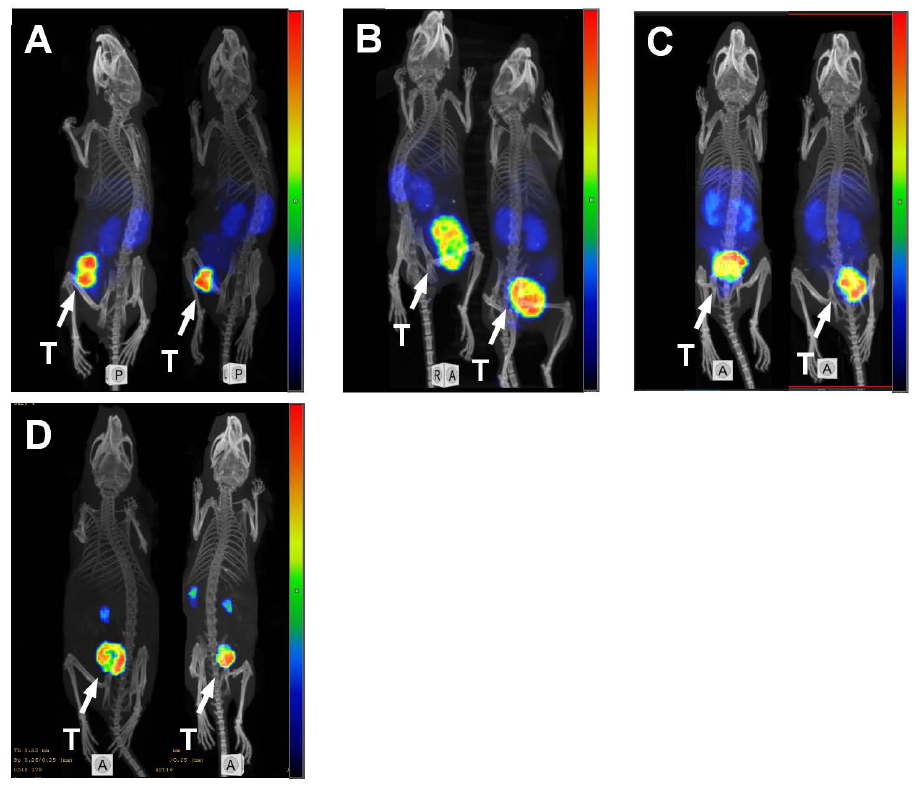
Figure 6. MicroSPECT/CT imaging of HER2-expression using 99m Tc-Z HER2:41071 in BALB/c nu/nu mice bearing SKOV3 xenografts. The imaging was performed at days 43 ( A ), 29 ( B ), 34 ( C ) and 77 ( D ) of the experimental therapy. Two mice from the ADAPT6-ABD-mcDM1 treated group with small tumors at day 43 ( A ) and day 77 ( D ), two mice from ADAPT Neg -ABD-mcDM1 treated group at day 29 ( B ) and two mice from PBS treated group at day 34 ( C ) with large tumors. The arrow with the letter “T” points to the